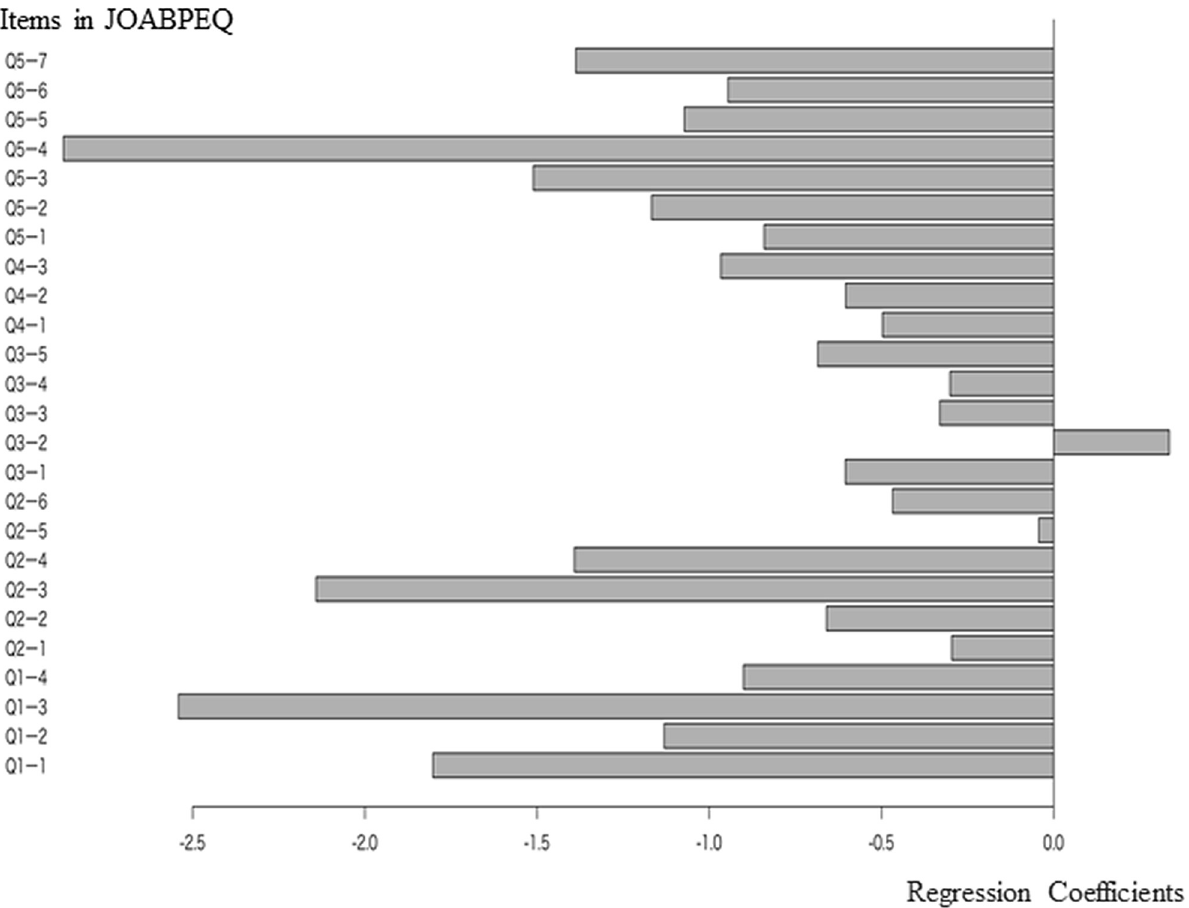
Fig 2. Regression coefficients of each JOABPEQ item for the degree of lower back pain.